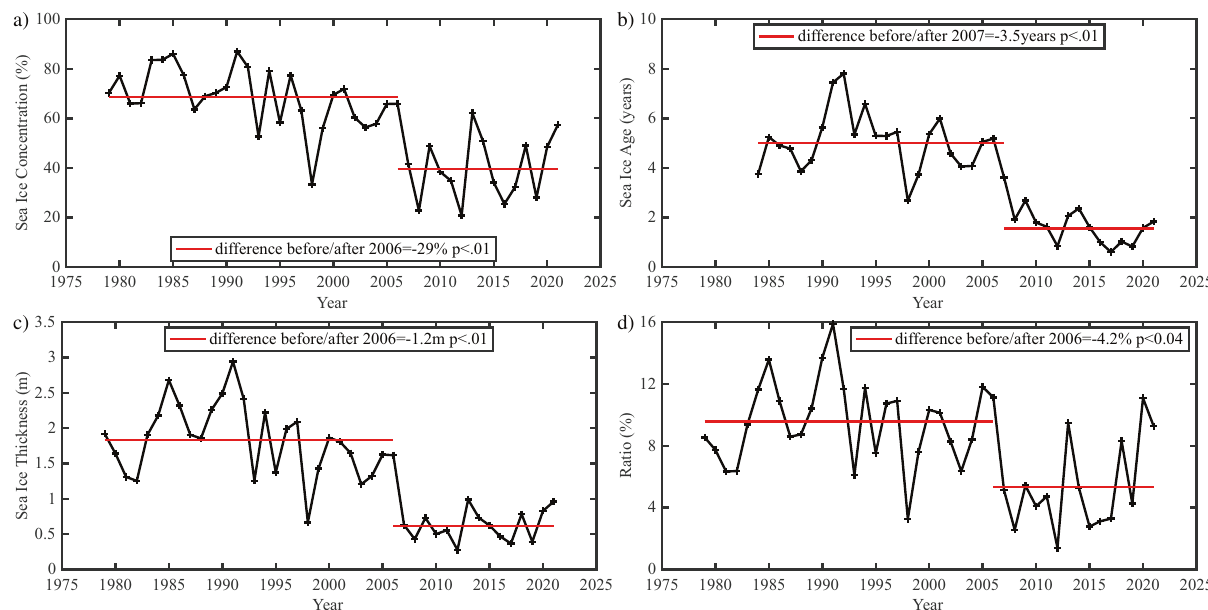
Fig. 2 Characteristics of summer (July – September) Beaufort Sea ice. Time series of the: a sea ice concentration (%) from the NSIDC CDR dataset 1979 – 2021; b sea ice age (years) from the NSIDC dataset 1984 – 2021; c sea ice thickness (m) from PIOMAS 1979 – 2021 and d ratio of the volume of Beaufort sea ice to Arctic sea ice from PIOMAS 1979 – 2021. In all cases, the red lines represent the step function fi t with the speci fi ed breakpoint that minimizes the root-mean square error in the fi t. The statistical signi fi cance of the step is indicated in the legend.